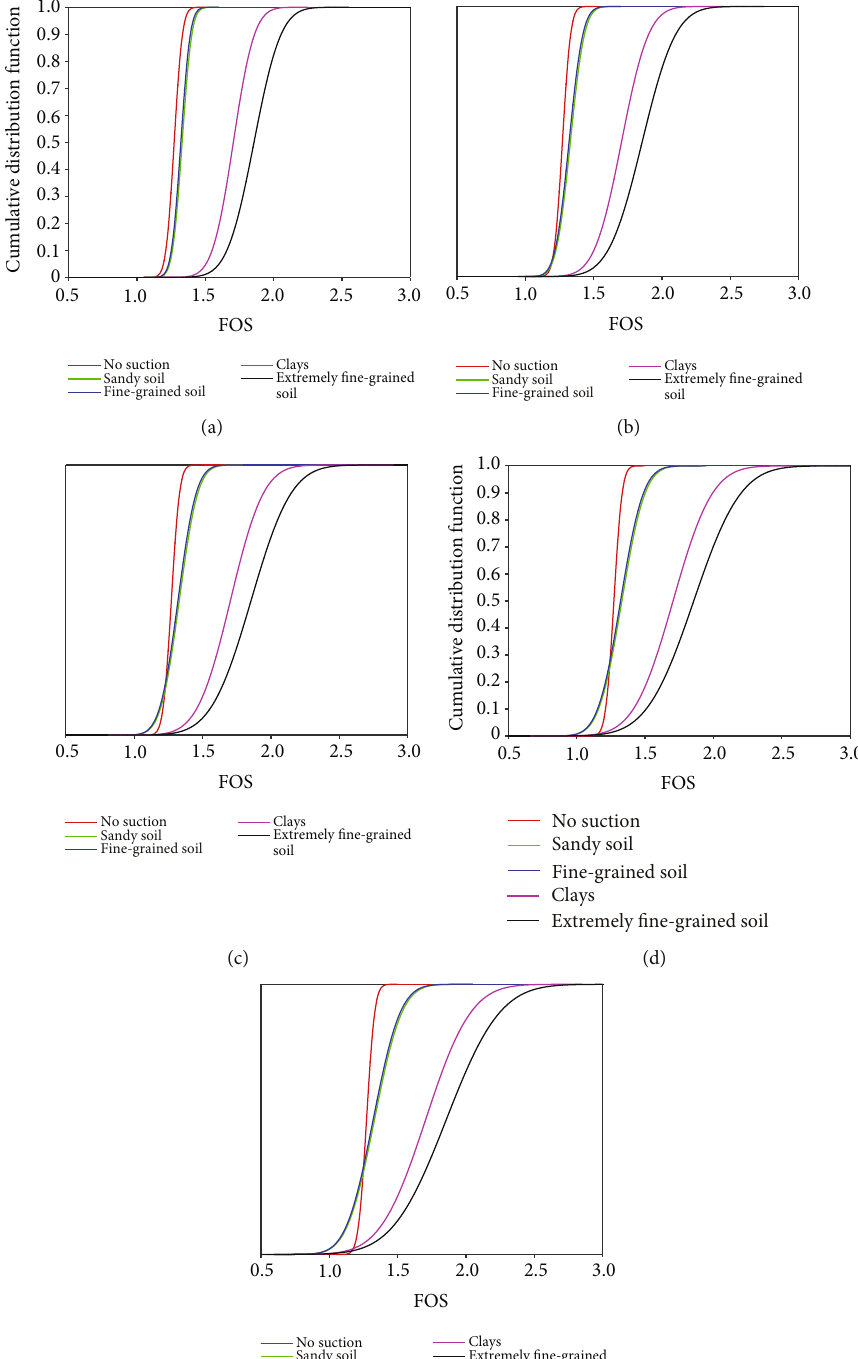
= − 1 : 0 , (b) ρ c ′ tan ϕ ′